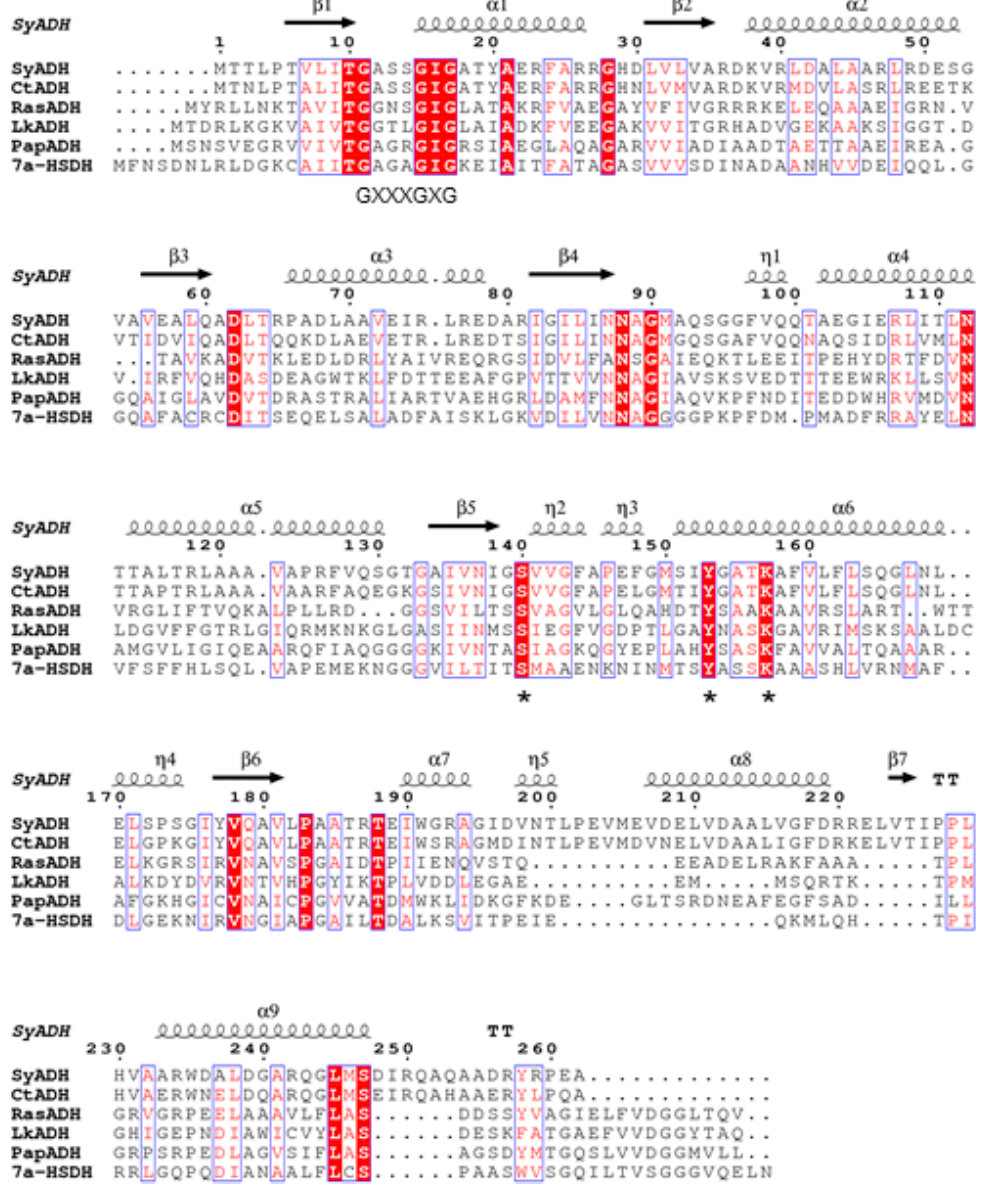
Figure 1. Multiple sequence alignment of CtADH, SyADH (genbank: EU427523.1) and PapADH (EU427522.1); RasADH (ACB78191.1), LkADH (AY267012.1) and 7 α‐ HSDH (AJP09756.1), illustrated (EU427522.1), RasADH (ACB78191.1), LkADH (AY267012.1) and 7 α -HSDH